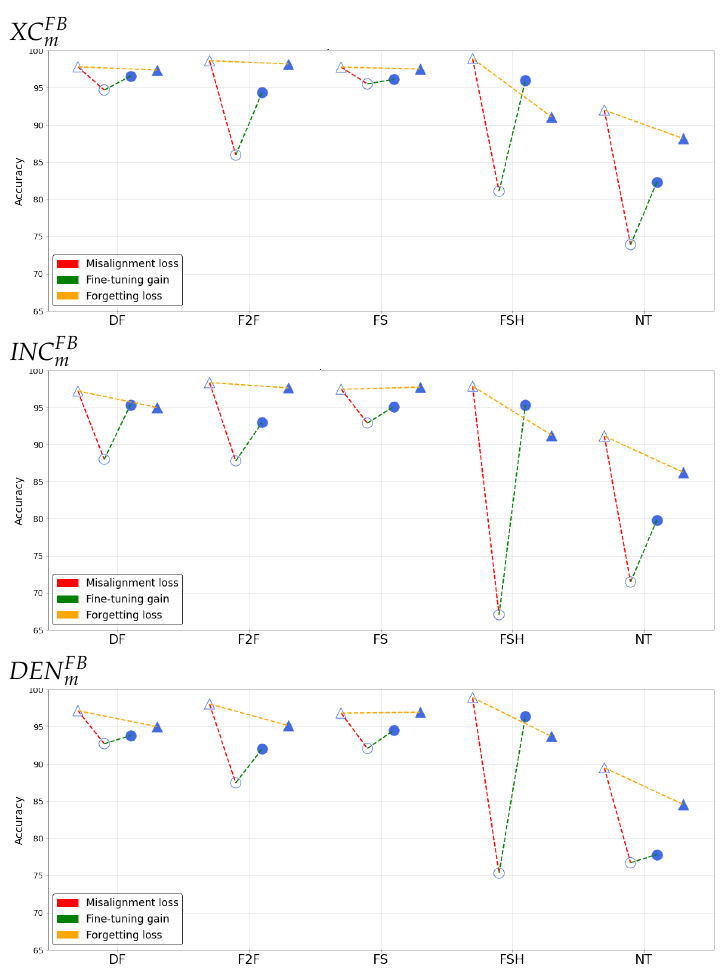
Figure 4. Accuracy results in the post-social scenario on FB